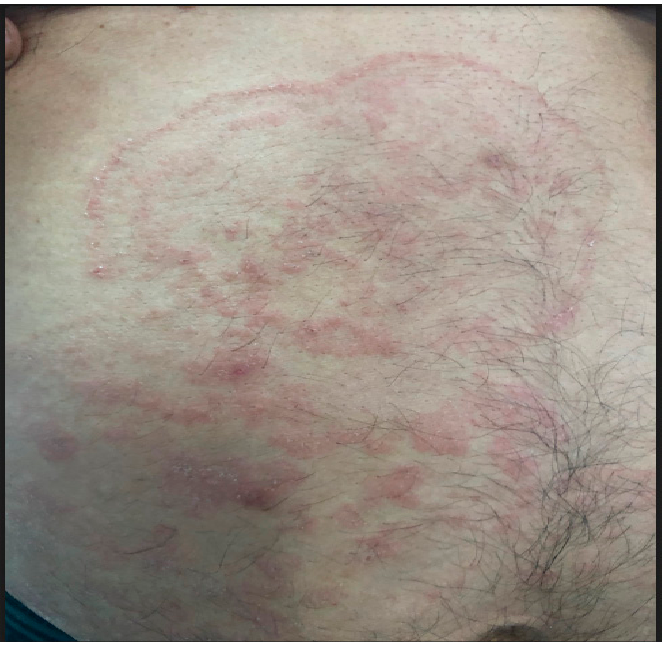
Figure 1. Cutaneous lesions caused by T. rubrum affecting the patient.